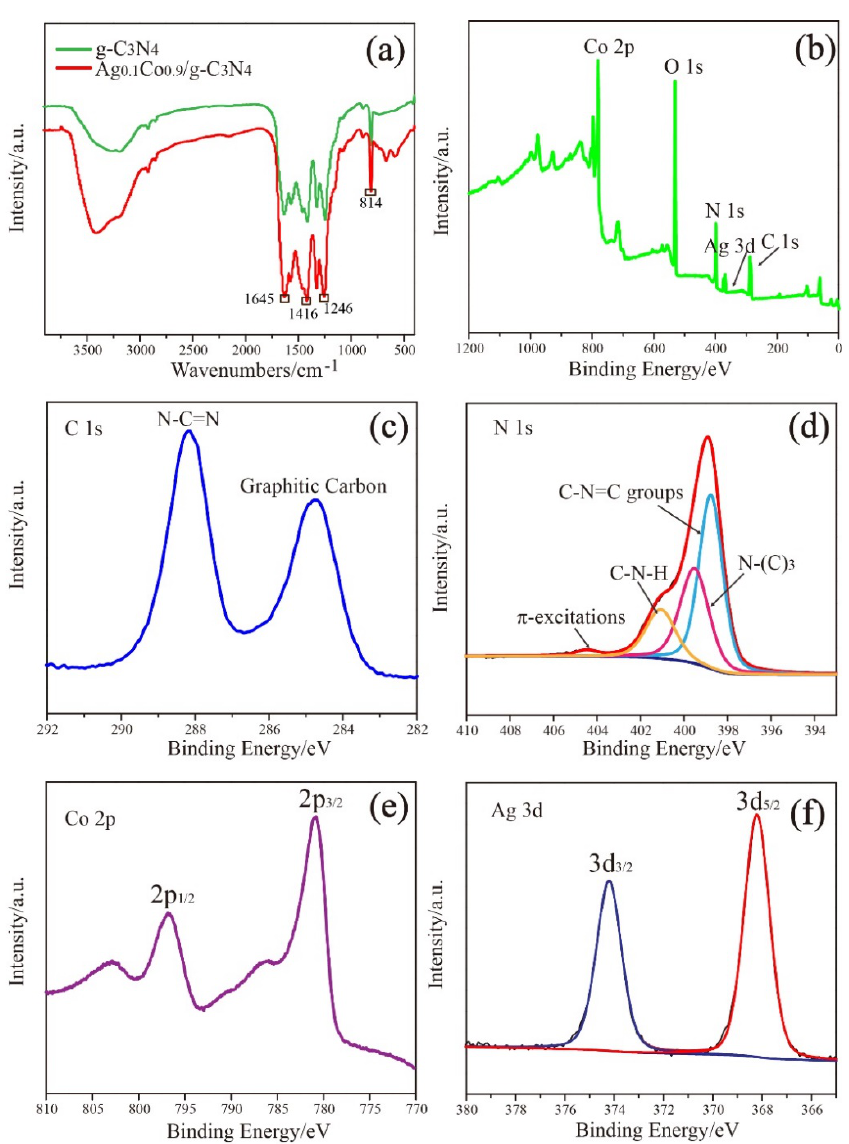
Figure 2. ( a ) FTIR spectra of g-C 3 N 4 and Ag 0.1 Co 0.9 /g-C 3 N 4 . ( b ) XPS of the survey scan of the catalyst. XPS spectra of ( c ) C 1s, ( d ) N 1s, ( e ) Co 2p, and ( f ) Ag 3d.